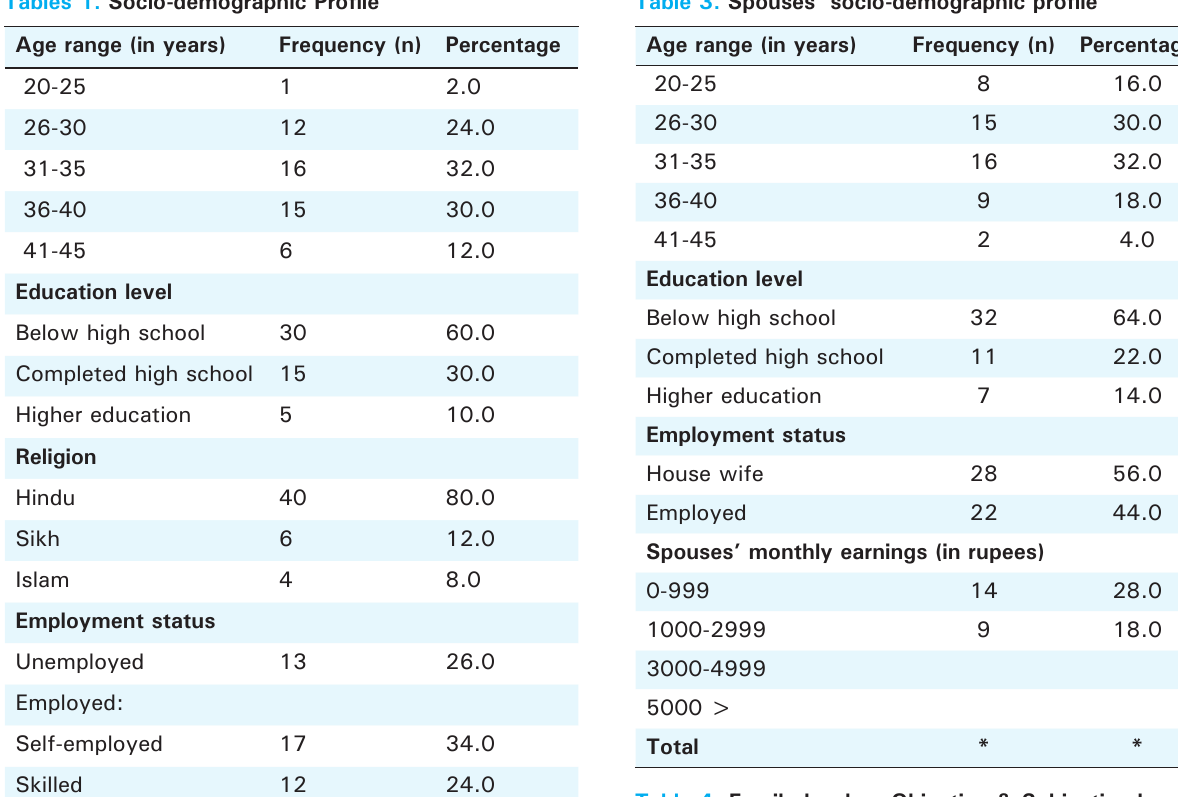
Table 4. Family burden: Objective & Subjective burden